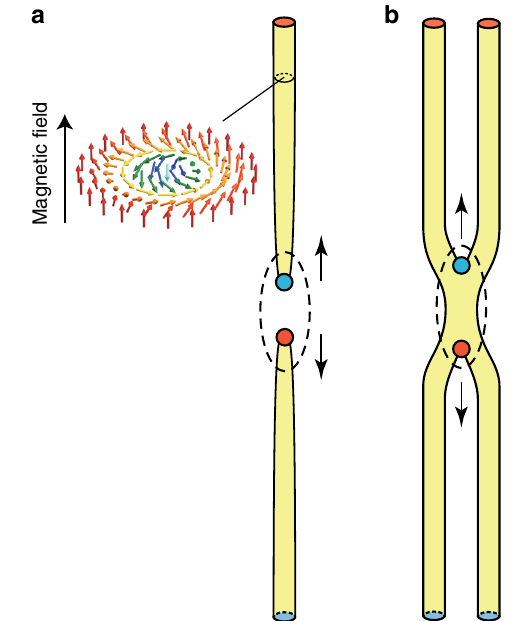
Fig. 1 Schematics of the emergent magnetic monopole and antimonopole. a , b Monopoles/antimonopoles resulting from the pinching-off of a skyrmion string ( a ) and partial merging of two neighboring skyrmion strings ( b ). Colored circles represent emergent magnetic monopoles/ antimonopoles. Arrows indicate expected motions of the monopoles/ antimonopoles when the topological unwinding